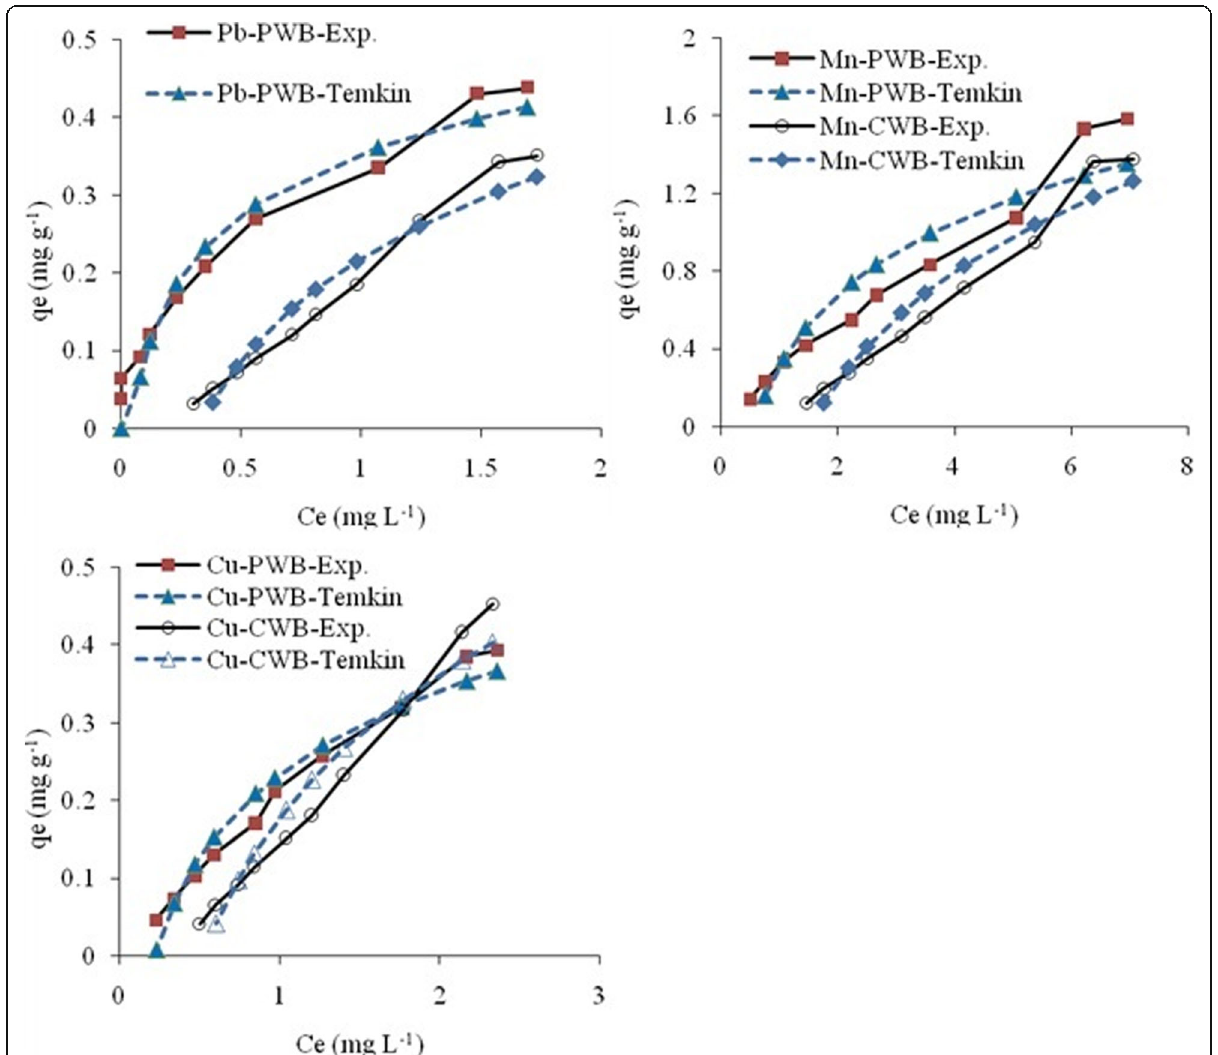
Fig. 6 Experimental and predicted adsorption of the heavy metals in landfill leachate onto PWB and CWB using Temkin